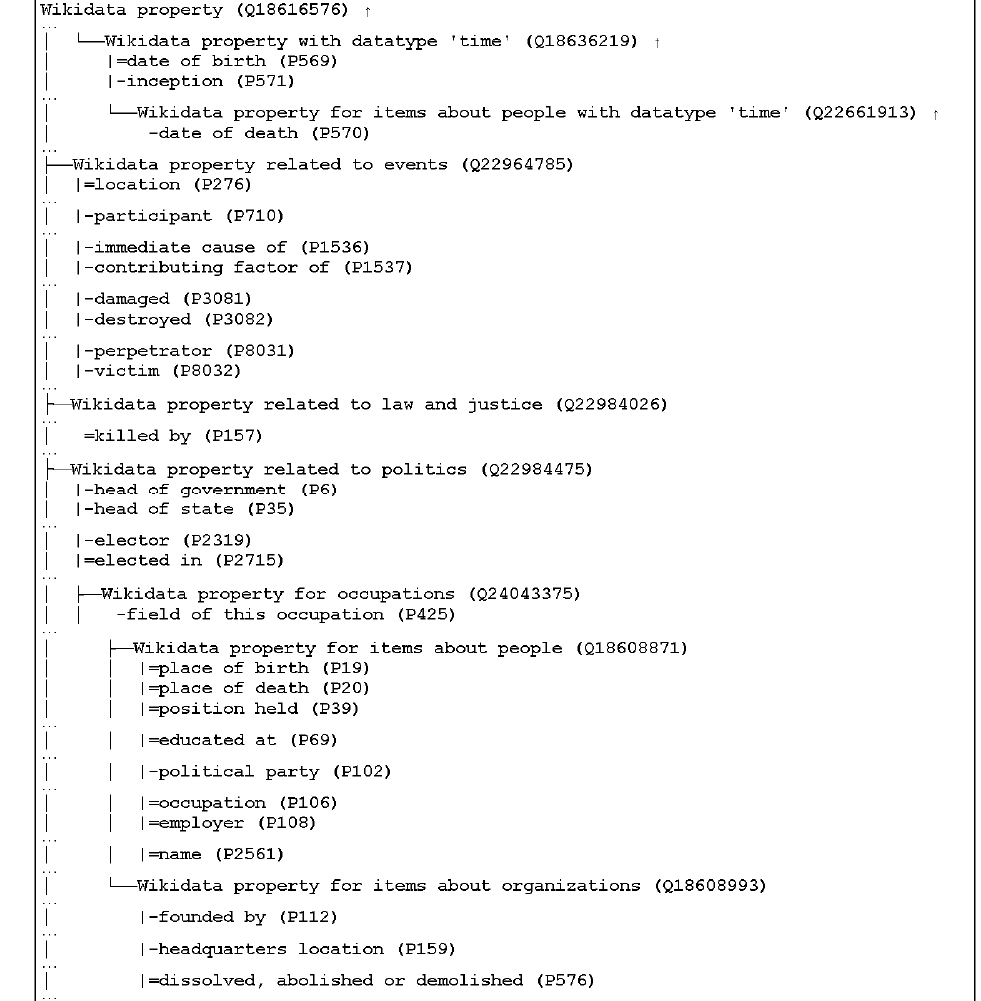
Figure 7. A portion of Wikidata property taxonomy, extracted by means of the Wikidata-taxonomy tool.